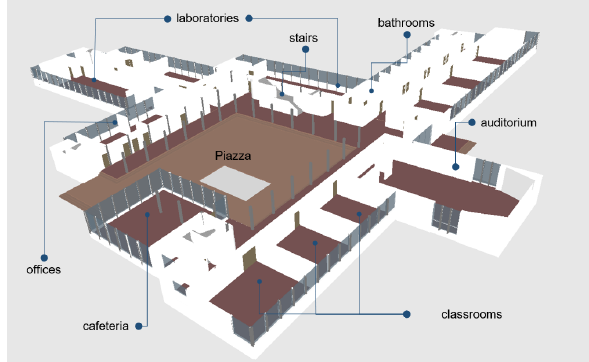
Figure 8. Ground floor CityGML model of the Agricultural Sciences Building